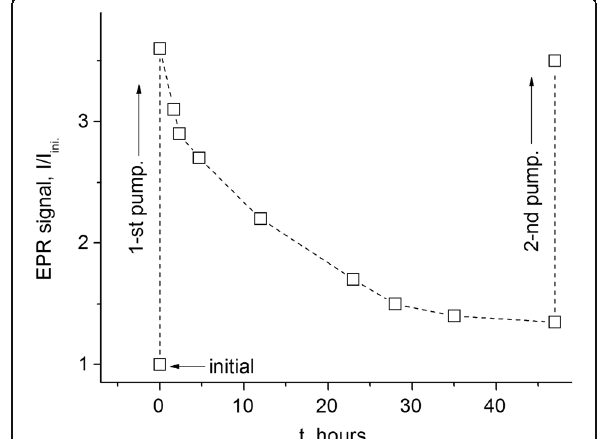
Fig. 5 The decline of the EPR signal of the bulk composite sample PhC-2 + 3% FS ( d ~ 1.5 × 3 × 3 mm 3 ) after evacuation during 1 h at T = 160 ° C. The contact of the sample was set with the environment after evacuation